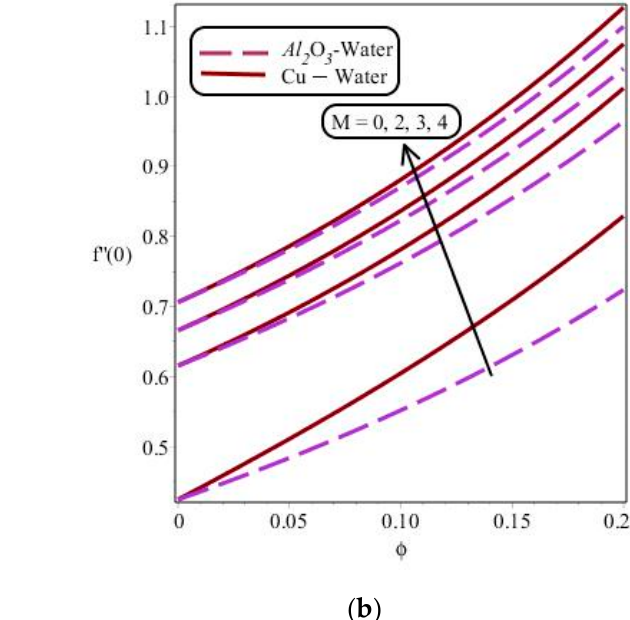
( a ) ( b ) Figure 11. ( a , b ) Impact of M and 𝐾 (cid:3033) on surface force and temperature gradient with β = 0.7, N = 0.5, K 1 = 0.7, and M = 0.2. 5. Conclusions In this article, we studied the effects of the inclined magnetic field, velocity slip, po- rous medium, and thermal radiation on a nanofluid passed over a cloth for stretching. For the prescribed surface, this study evaluated temperature with two kinds of nanofluids ( 𝐶𝑢 –water and 𝐴𝑙 (cid:2870) 𝑂 (cid:2871) –water). The inclined magnetic field obtained appeared enforceable with an aligned angle, in which the aligned angle ranged between 0 and 𝜋/2 . The fol- lowing were the dominant basic results: •